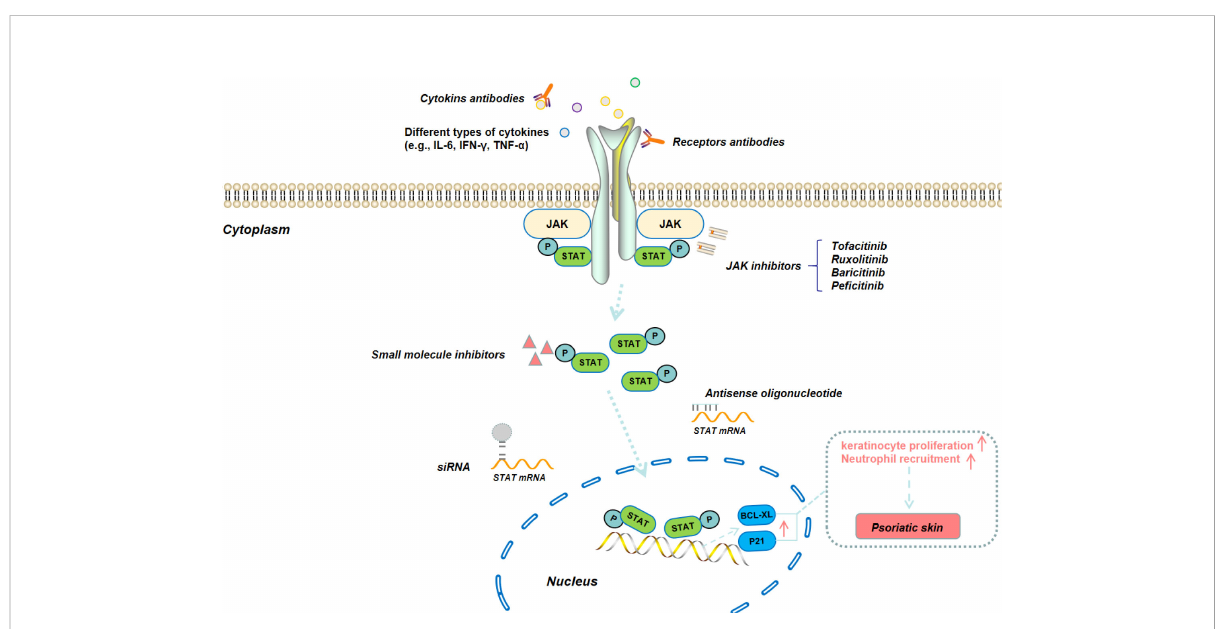
FIGURE 2 The PI3K/AKT/mTOR signaling